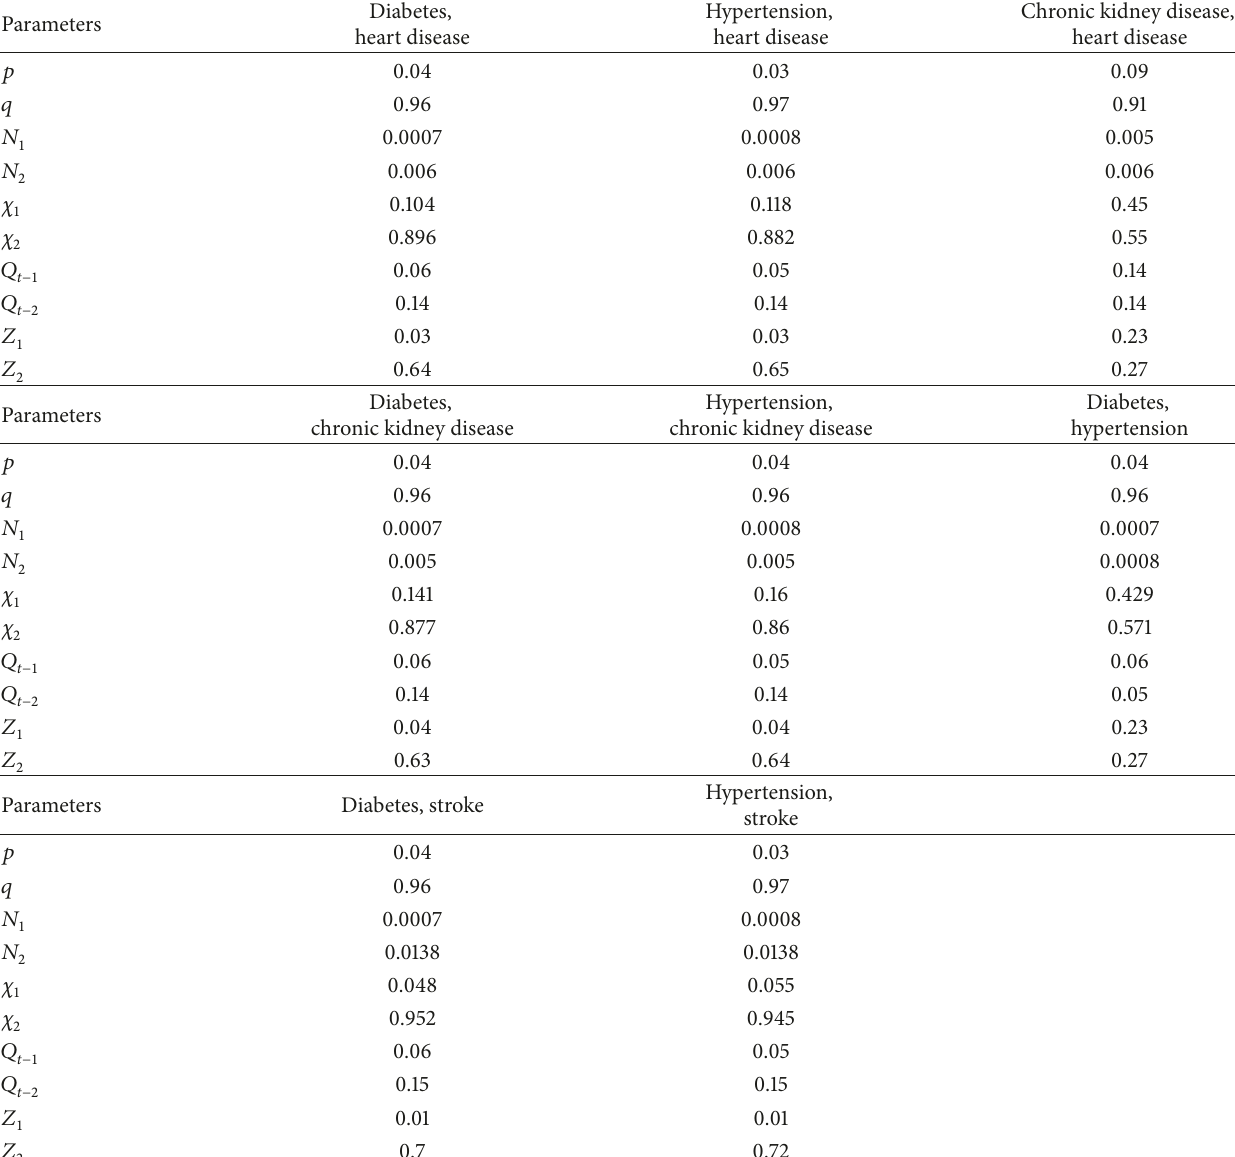
Table 1: Relative comparison of risks in several chronic conditions of